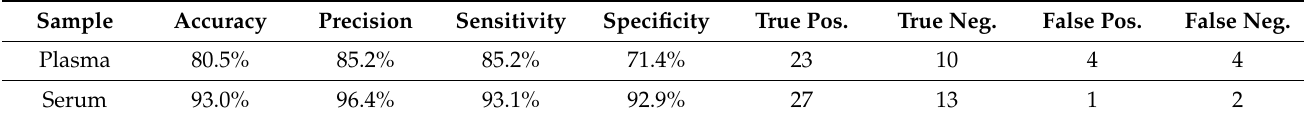
Table 3. PCA-LDA results on plasma and serum samples for 1200–1700 cm − 1 spectral region. Sample Accuracy Precision Sensitivity Specificity